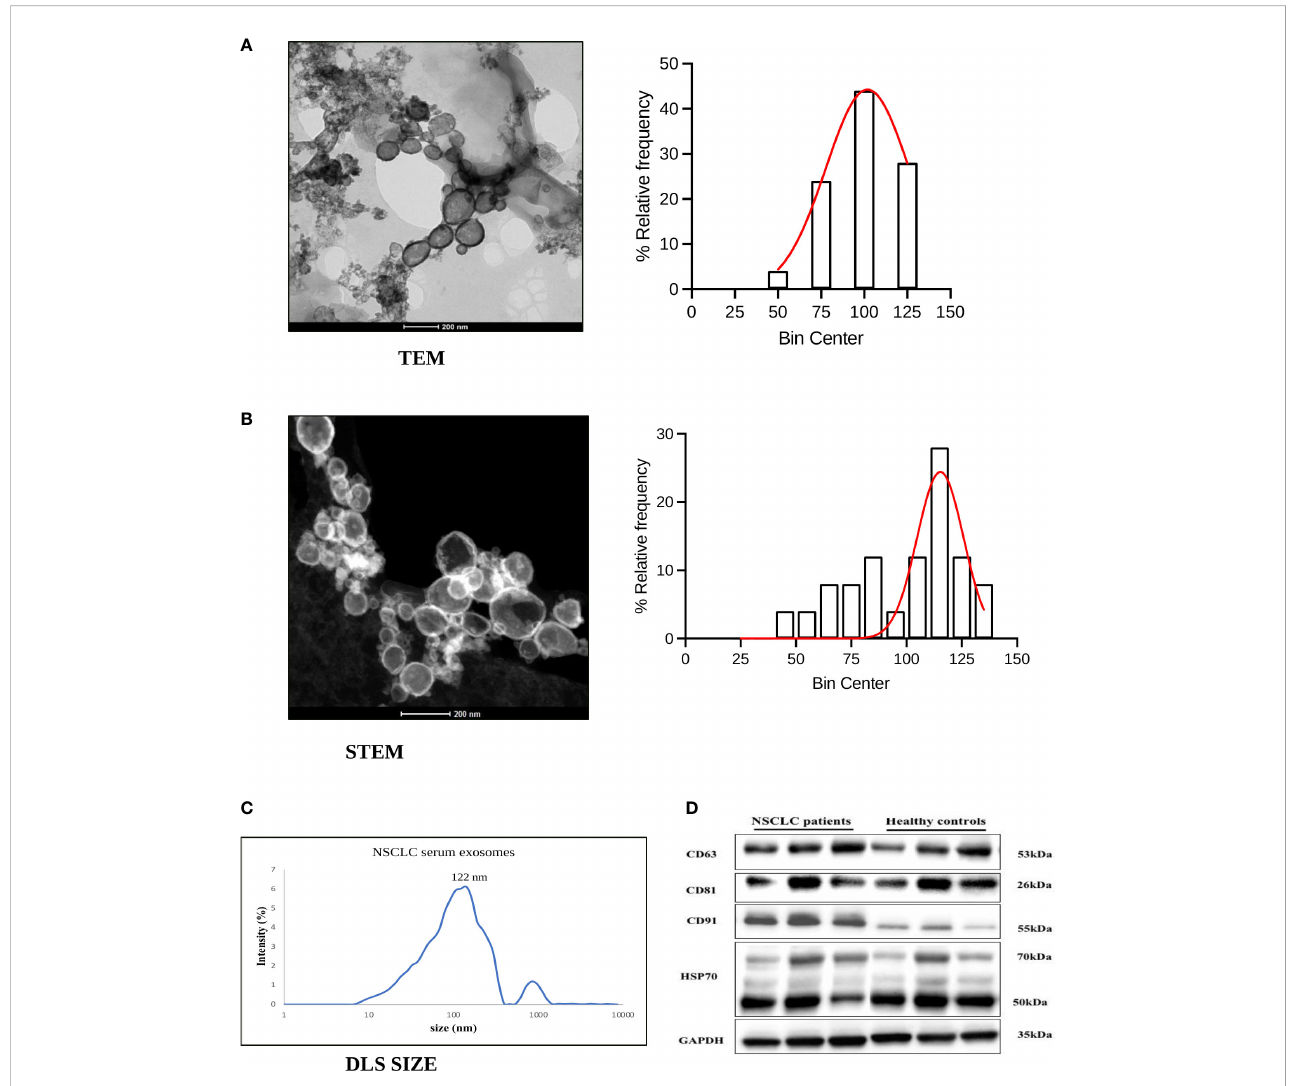
FIGURE 1 Characterization of exosomes derived from serum of NSCLC patients. (A, B) Representative fi gure and histogram with the gaussian curve (bin centre=25nm) of transmission electron microscopy (TEM) and Scanning Transmission electron microscopy (STEM) showing characterization for exosome morphology and size distribution of exosomes derived from NSCLC patients (C) Hydrodynamic size measurement of exosomes by Dynamic Light Scattering (mean value 122nm). (D) Representative western blot images showing expression of exosome-speci fi c markers CD63, CD81, HSP70, and lung cancer protein CD91 among NSCLC patients and healthy